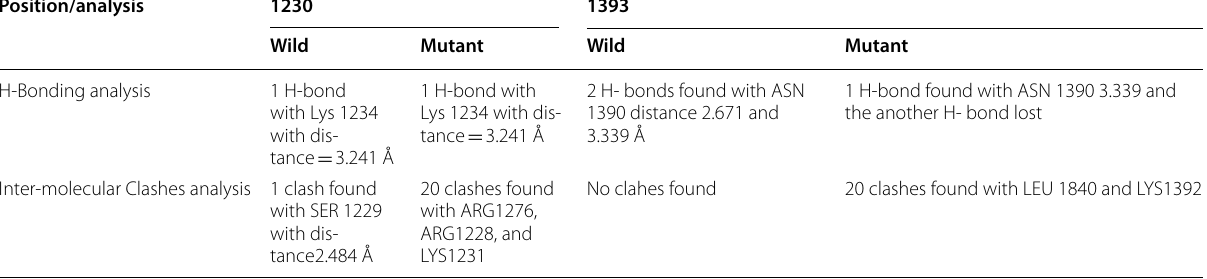
Table 11 Inter‑molecular H‑ bonding and Clash Analysis of Wild and mutant structure of modeled PLCε1 according to chimera Position/analysis